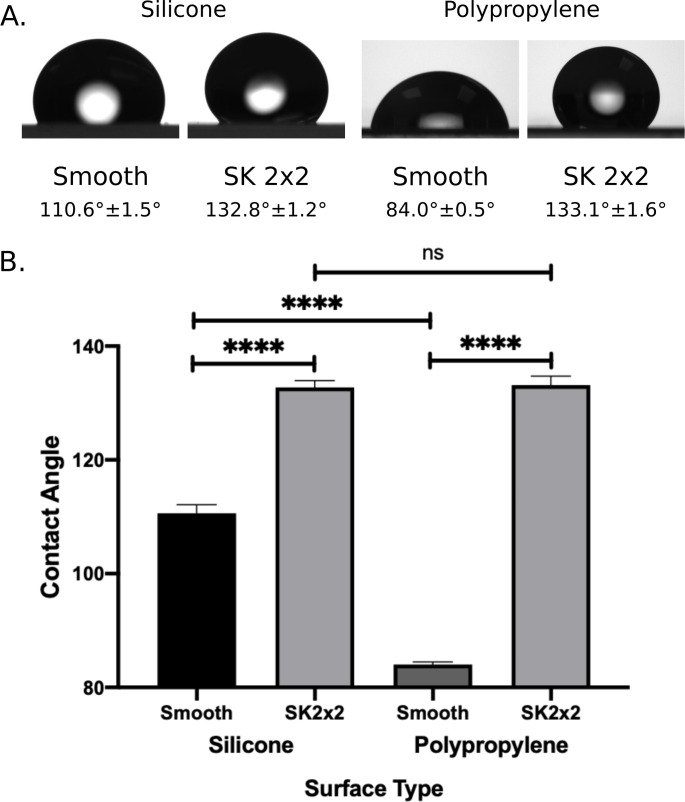
Effects of SK micropatterns on surface wettability.(A) Representative images of water drops captured by a goniometer on smooth and SK2x2 silicone or polypropylene surfaces. Water contact angles are reported belowimagesby mean ± SEM (silicone, n = 8; smooth polypropylene n = 16; SK2x2 polypropylene, n = 22). (B) Comparison of water contact angle on different surfaces, error bars represent SEM. Statistical significance was determined by ordinary one-way ANOVA followed by Holm-Sidak’s multiple comparison test (****, p < 0.0001; ns, not significant, p > 0.05, p > 0.05).